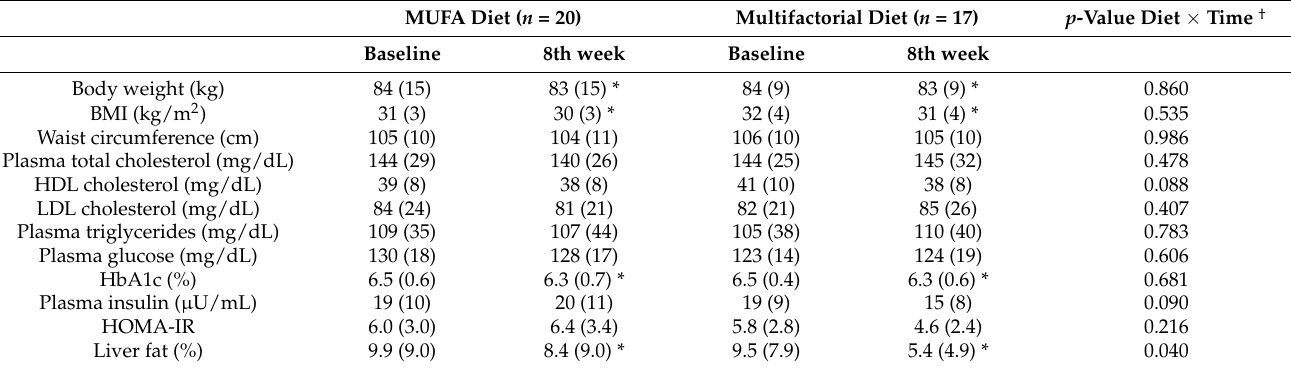
Table 1. Anthropometrics, metabolic parameters, and liver fat content at baseline and after the 8-week intervention in participants who completed the trial.